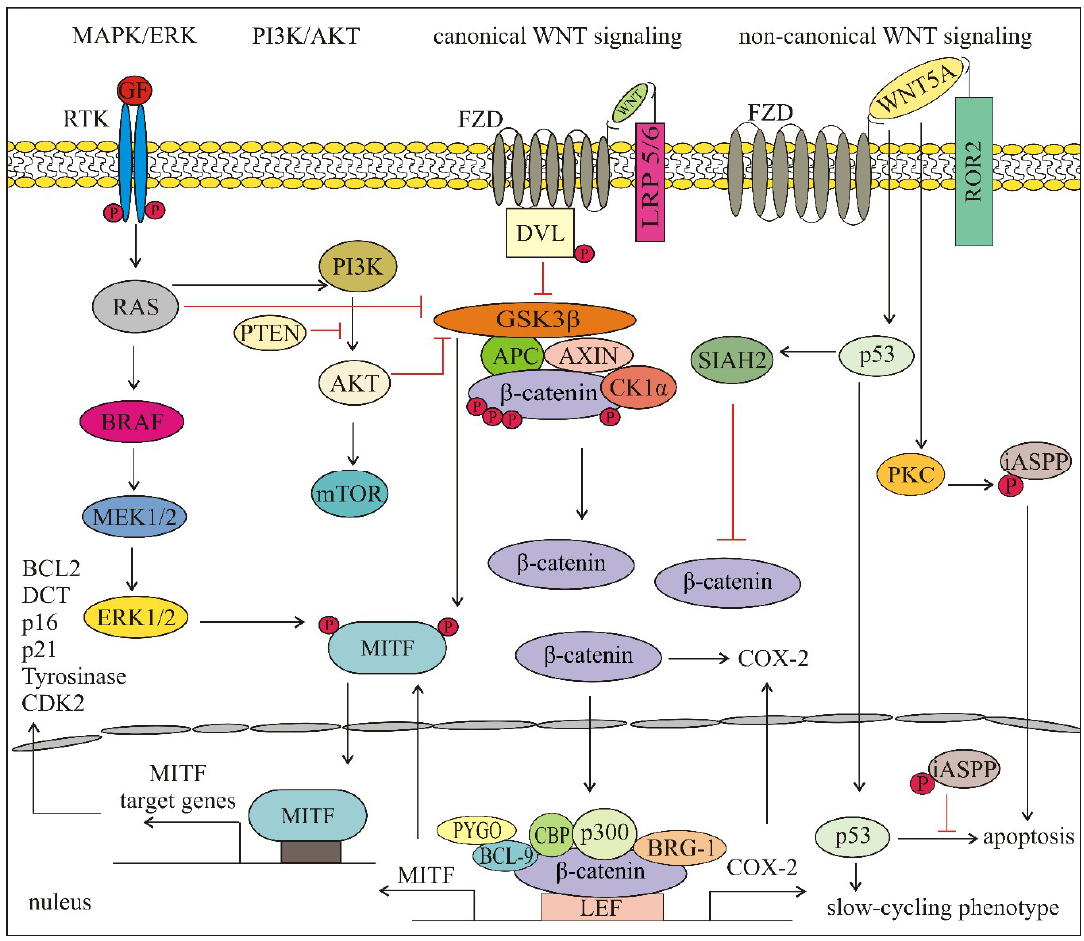
Figure 4. Main signal transduction pathways and transcriptional regulators that interact with the WNT-signaling pathways in melanoma. Figure shows the possible crosstalk between different pathways, however, some of the interactions are genetic context-, disease stage- or treatment-dependent. See the text for more details. APC—adenomatosis polyposis coli; AXIN—axis inhibition protein; BCL—B-cell CLL/lymphoma